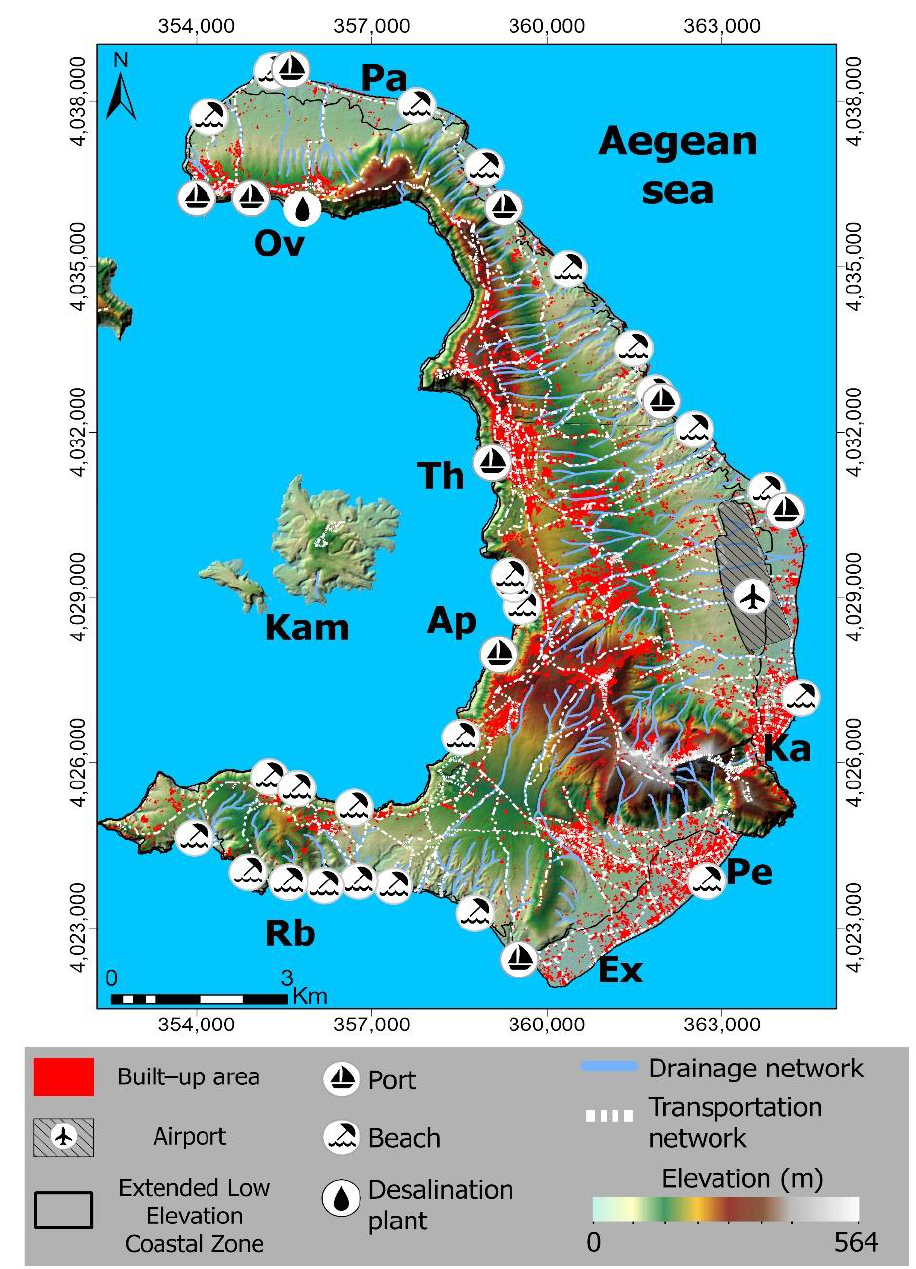
Figure 3. Map of Thira Island illustrating the input of geospatial analysis, such as seaports, beaches, desalination plant and mines. Ka: Kamari, Pe: Perissa, Ap: Athinios, Rb: Red beach, Ex: Exomitis, Th: Thira, Pa: Paradisos, Ov: Oia and Kam: Kameni. Table 1. Datasets used for multi-hazard modelling.